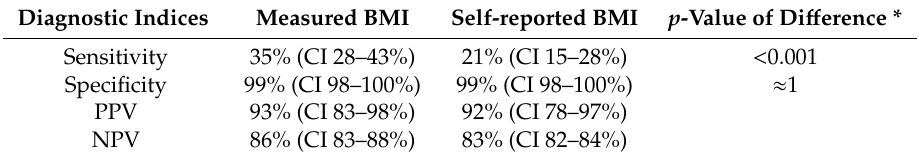
Figure 2. Receiver operating characteristics (ROC) curve for measured BMI and self-reported BMI. Table 3. The validity of obesity by measured BMI and self-reported BMI measured by several diagnostic